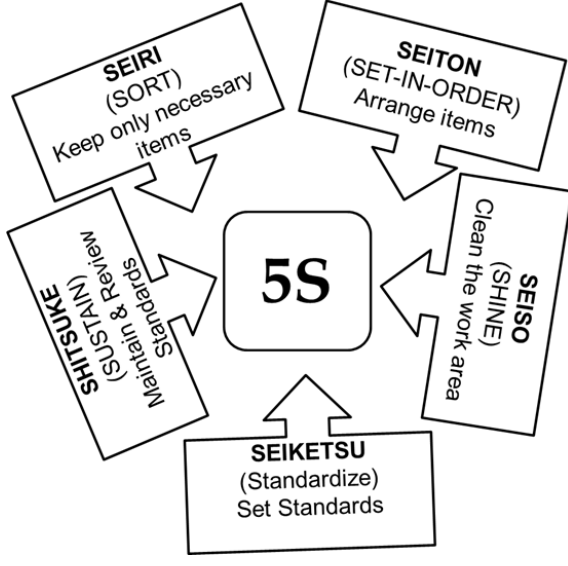
Fig. 1. Illustration of the concept of